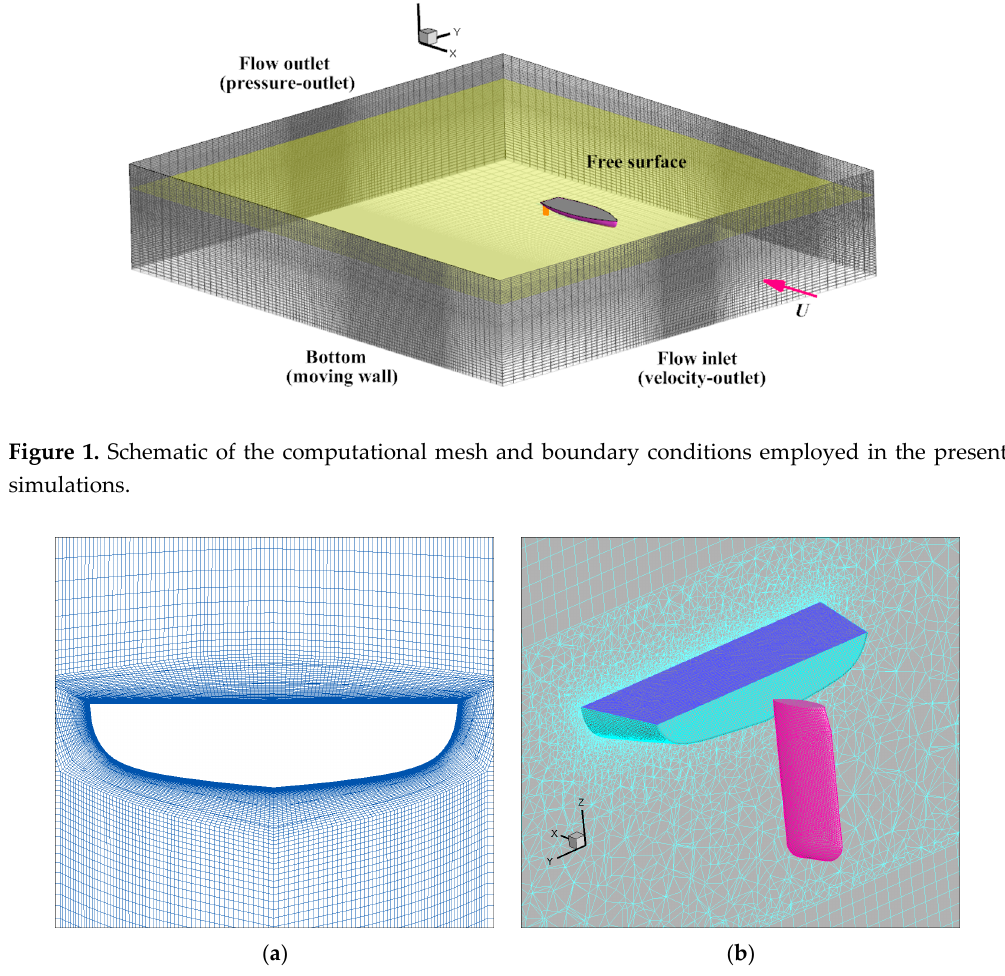
Figure 2. Schematic of the computational mesh of hull and rudder: ( a ) is hull and ( b ) is rudder